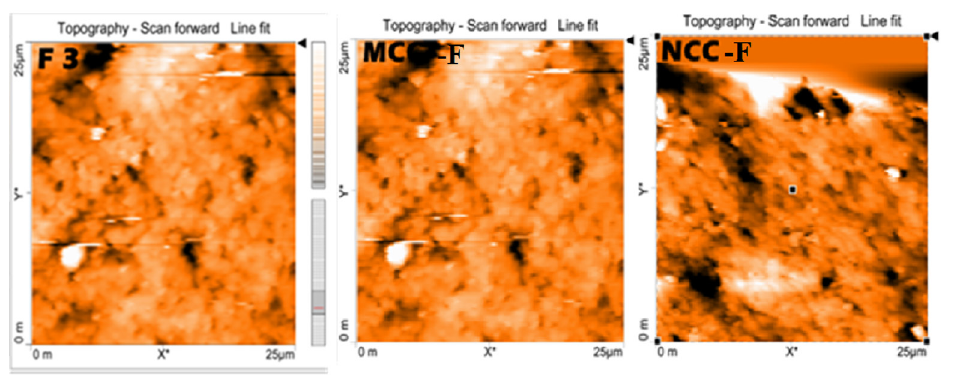
FIGURE 5 - AFM images of F3, MCC-F and NCC-F